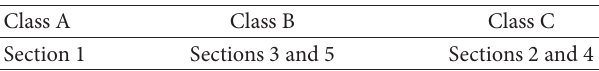
Table 3: Results of the first phase of the section classifying